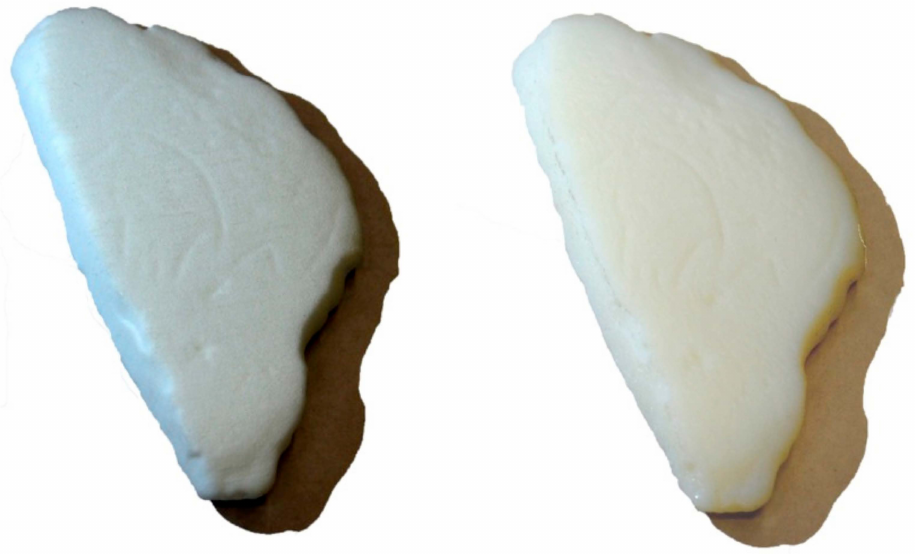
Figure 4. ( left ) Replica in Nylon PA 12; ( right ) replica in glass-filled